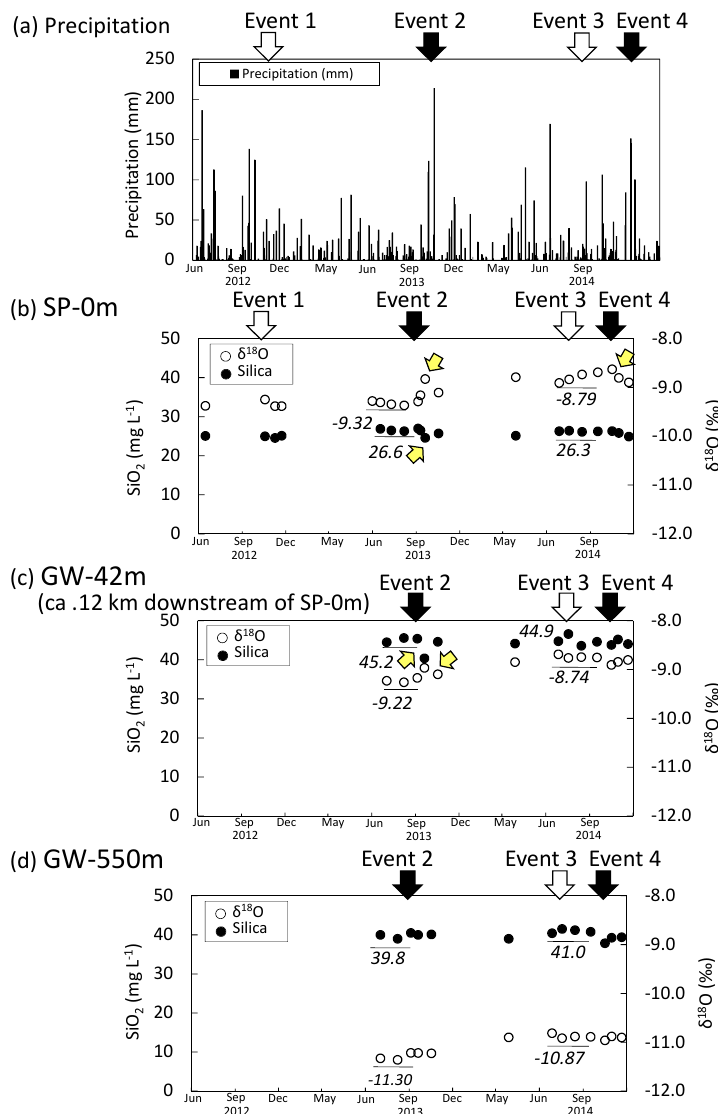
Figure 2. Changes in oxygen isotope ratio, concentration of silica. (a) Precipitation, (b) groundwater at SP-0m, (c) shallow groundwater at GW-42m, and (d) deep groundwater at GW-550m. Black and open arrows indicate the rainfall event: Event 1, Event 2, Event 3 and Event 4. Black arrows indicate the torrential rainfall. Yellow arrows indicate the signature of direct impact of rainfall. The number shows an average value of the plots